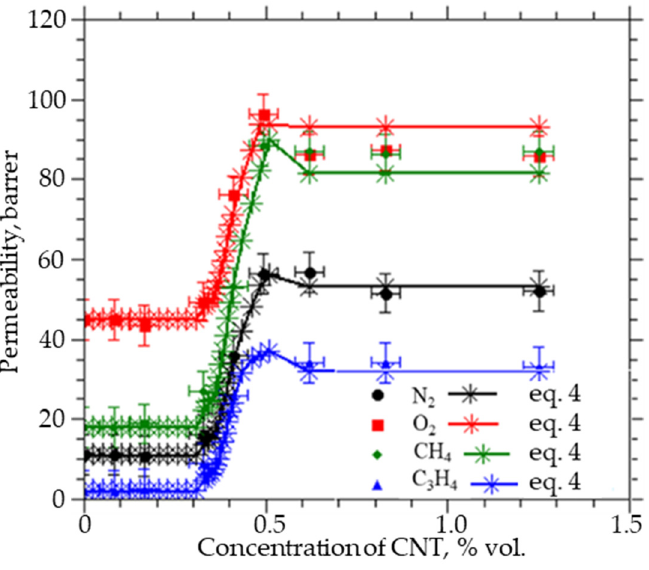
Figure 6. Permeability coefficients of nitrogen, oxygen, methane, and propane through PVTMS/CNTs membranes, taking into account agglomeration.